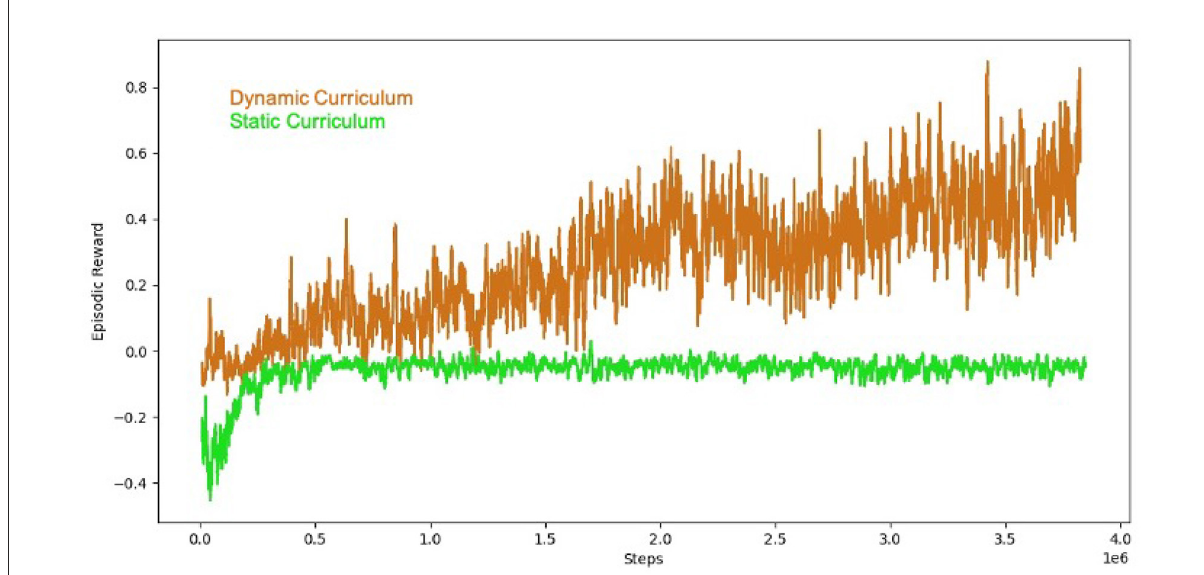
FIGURE6 Round-based curriculum training organized with the AI Arena (brown). Successive rounds of training increased the difficulty by slowing introducing safety penalties over three rounds of training with penalty weights (0, 0.05, 0.1, 0.15, 0.20, 0.25, 0.3). The baseline (green) starts with the penalty threshold of 0.3. The result illustrates the value of successive rounds of curriculum training for teams of tanks in the AI Safety Challenge